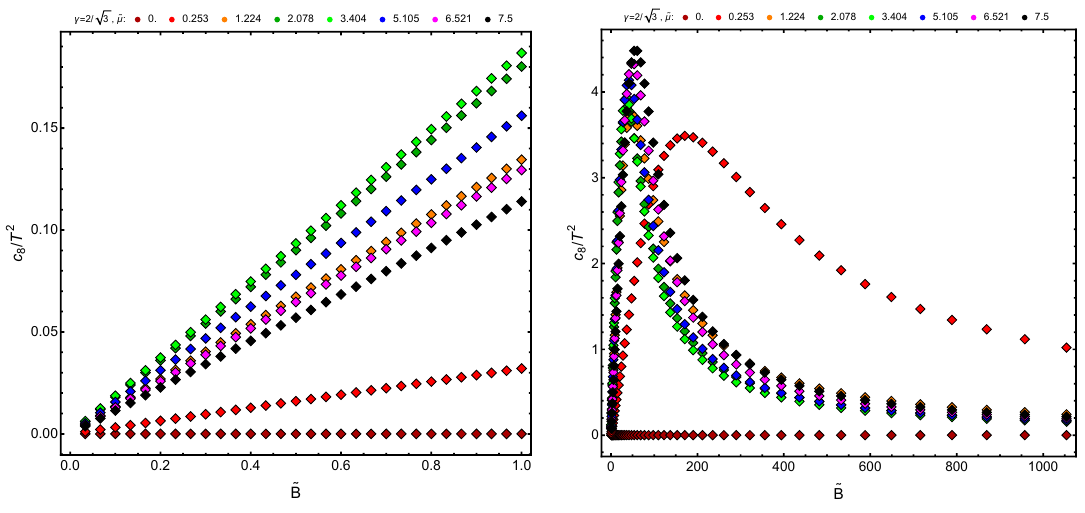
Figure 14 . The transport coefficient c 8 /T 3 for small and large magnetic fields in presence of √ the chiral anomaly γ = 2 / 3 . Without chiral anomaly or for vanishing chemical potential, the transport coefficients is